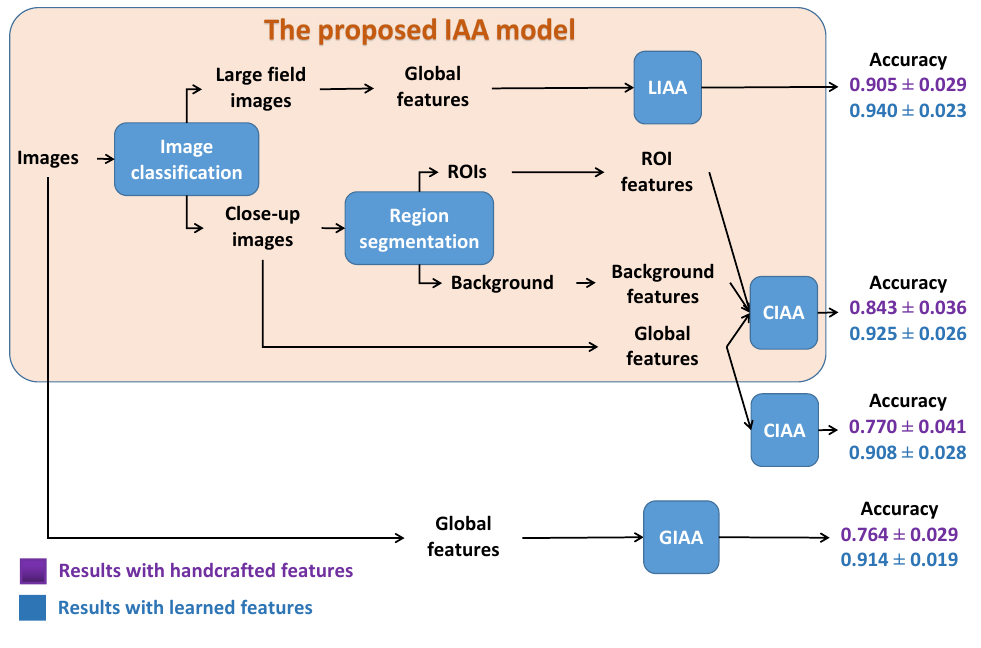
Figure 18. Proposed algorithm for